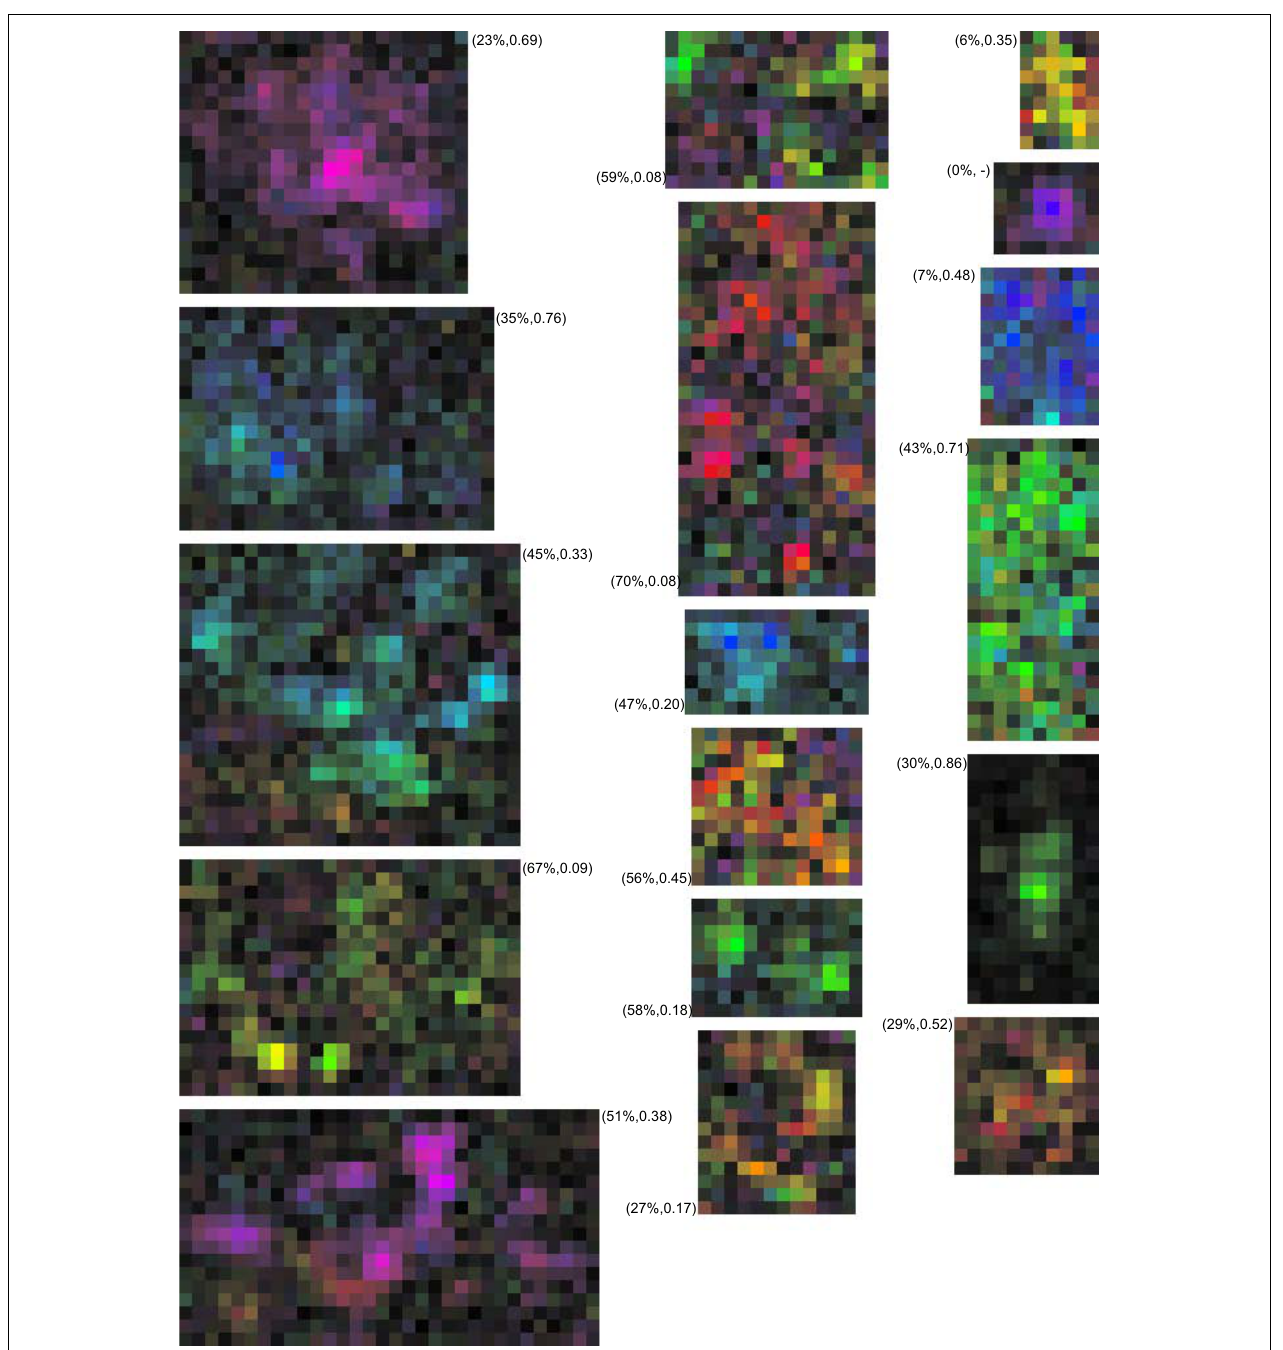
the valley-over peak-ratio for each neuron.While difficult to capture in a single, quantitative measure these examples show that a description in terms of a single hill of sensitivity does not capture the complexity of the MT RF. In our sample 24% of neurons had such non-monotonic receptive fields.